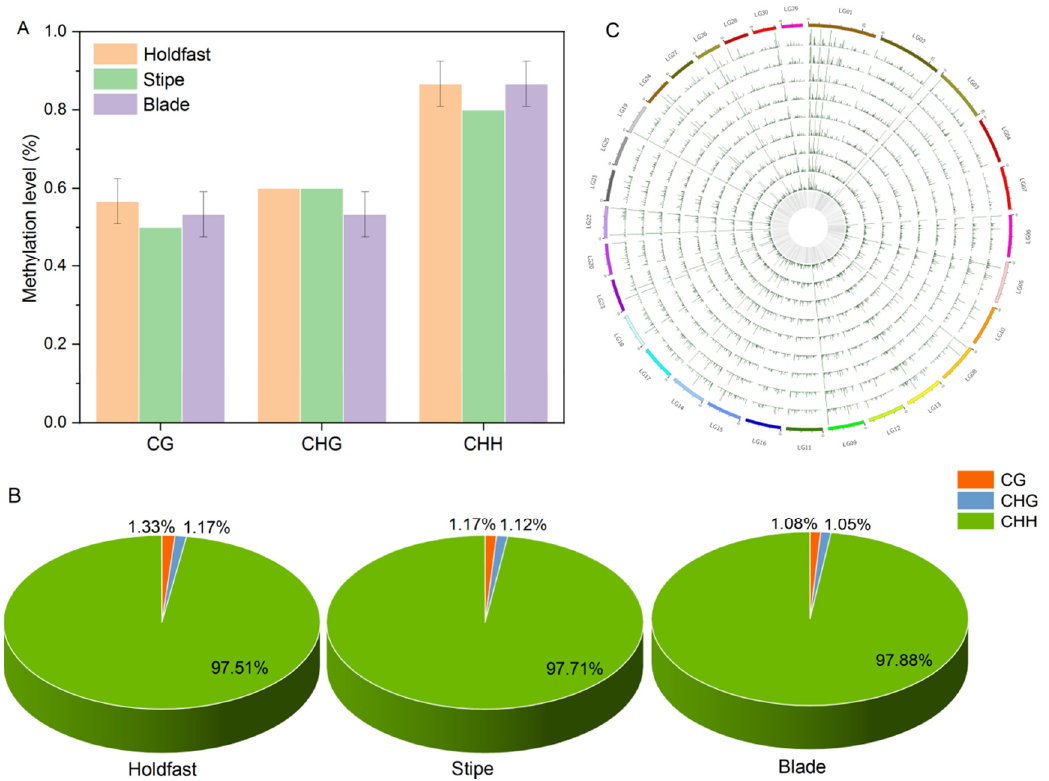
Figure 1. Whole-genome DNA methylation status and chromosomal distribution of S. japonica sporophytes. ( A ) DNA methylation levels in holdfast (navajo white), stipe (light green) and blade (medium orchid). ( B ) The relative content of methylated cytosines in CG (dark orange), CHG (cornflower blue) and CHH (lime green) contexts. ( C ) The landscape of DNA methylation in the 31 chromosomes of sporophyte. From outside to inside, the outermost circle is the scale divided according to the corresponding chromosome length. The following nine circles show the genome-wide landscape of DNA methylation in blade (B3–B1), stipe (S3–S1) and holdfast (H3–H1). The innermost circle indicates the gene numbers in the corresponding region. The higher the lines, the higher the methylation levels. B, H and S are the samples of blade, holdfast and stipe, respectively.